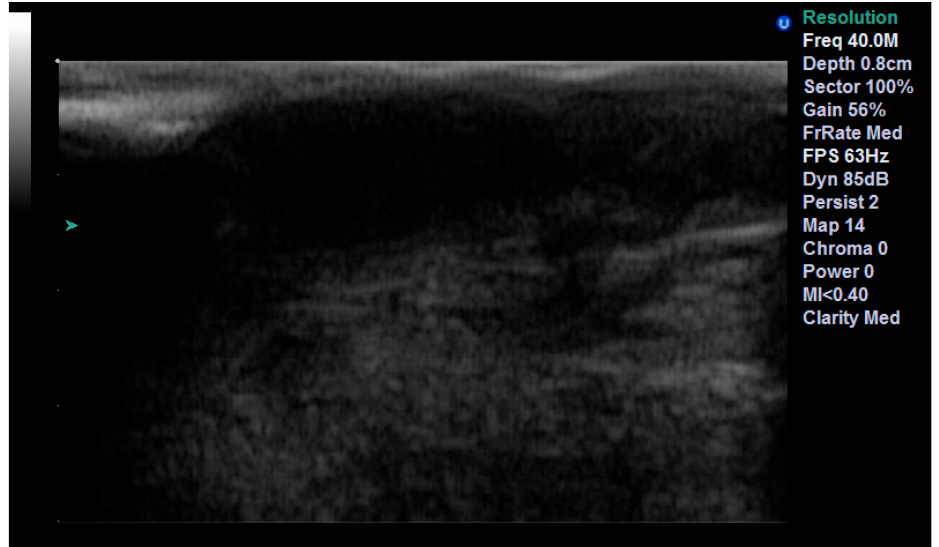
Figure 4. The arrow is showing the presence of the hyperechoic spots in a BCC and the pathological Figure 4. ThearrowisshowingthepresenceofthehyperechoicspotsinaBCCandthepathologicalcorrespondence. correspondence.